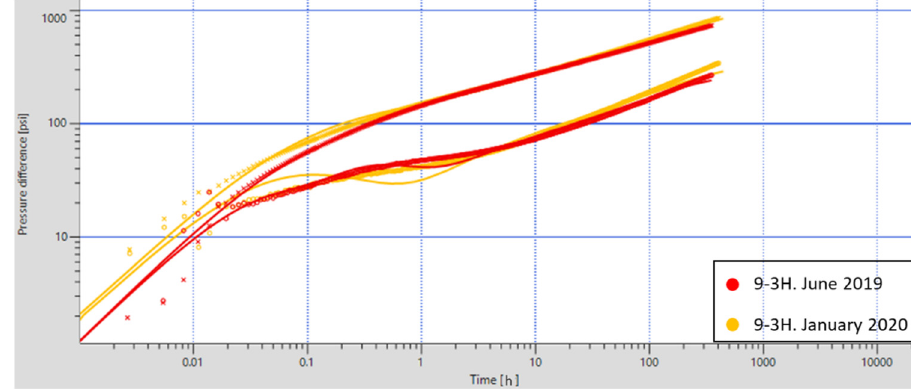
Figure 15. 9-3H well test curve. Figure 15. 9 ‐ 3H well test curve. Figure 15. 9 ‐ 3H well test curve.